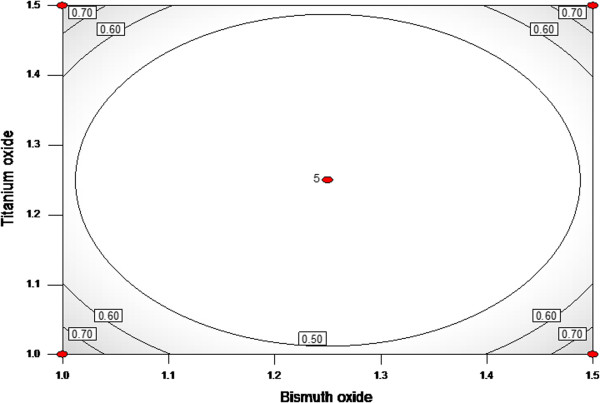
Contour plot of the experimental-design standard error with expanded axes, extrapolated area shaded.